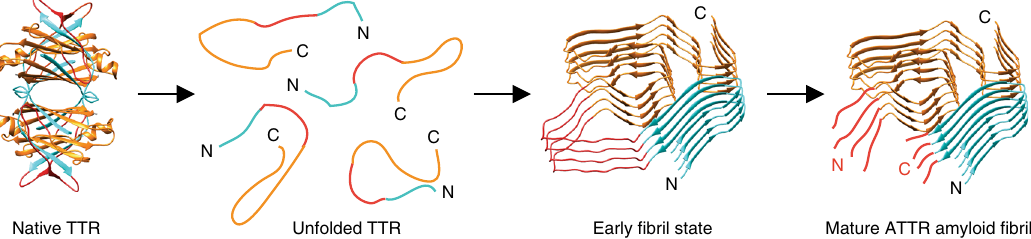
Fig. 6 Possible mechanism of misfolding of TTR protein. The fi rst step is the disassembly and unfolding of the native tetramer, followed by the assembly of the polypeptide chains into an early fi bril state. The last step is the proteolytic cleavage of TTR in the structurally disordered segment of residues Ala36- His56 (red) and the formation of the mature ATTR amyloid fi bril. The N- and C-terminal segments of the fi bril are colour coded orange and cyan,